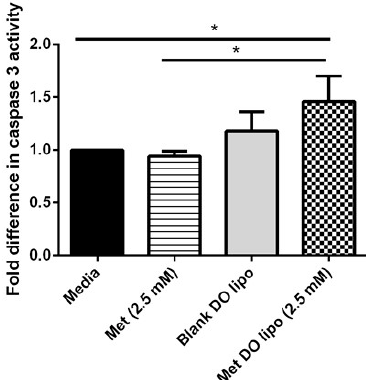
Figure 8. Effect of treatment on caspase-3 activity in MDA-MB-231 cells determined using EnzChek ® caspase-3 assay kit. A significant difference ( p < 0.05) is observed as compared to control and plain Met when treated with liposomal encapsulated met. Blank (drug-free) liposomal formulation did not show any significant difference compared to any of the treatment groups or control. Data represent mean ± SD ( n = 3). * p < 0.05 .